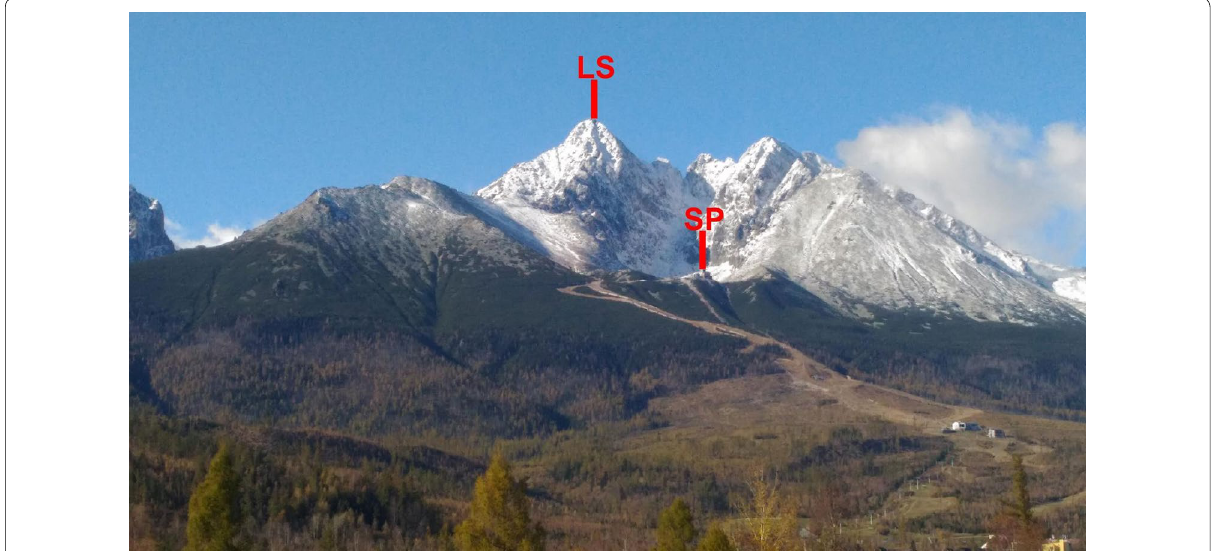
Fig. 1 View on Lomnický Štít with marked locations of observatories on its top (LS) and flank (SP)